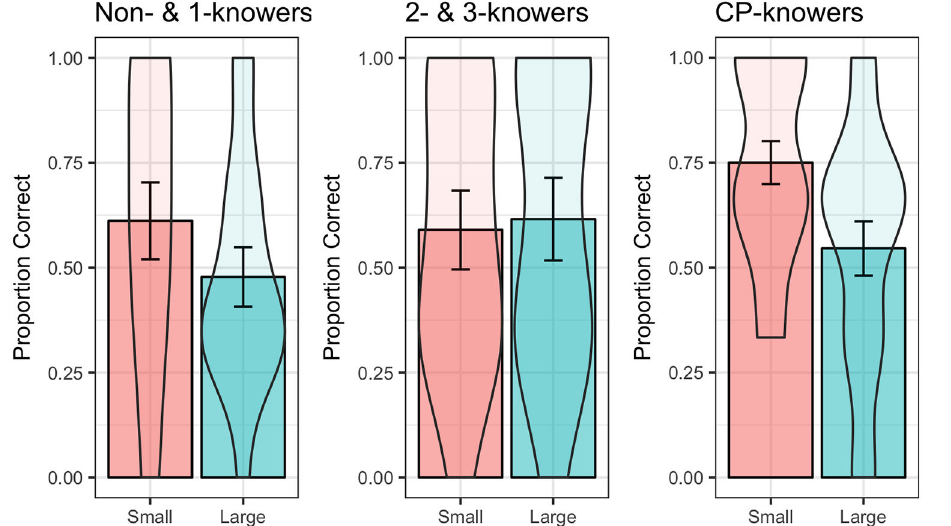
Figure 6. Overall proportion correct on small and large numerosity comparisons on incongruent trials, separated by knower- levels in Experiment 3. Only 2:3 ratio comparisons were included. Violin plots are used to depict the distribution and probability density of the data. Error bars represent standard errors of the